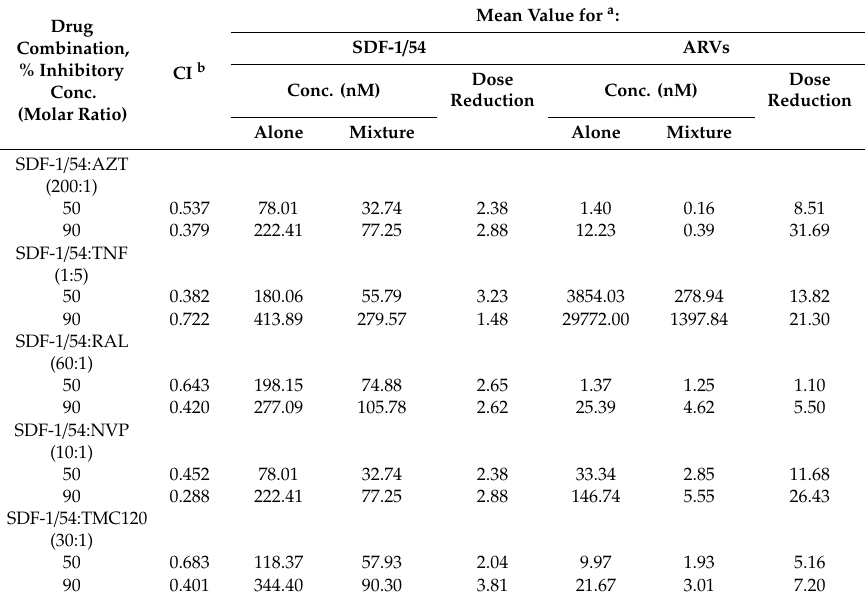
Table 6. Combination index and dose reduction values for inhibition of HIV-1NL4-3 infection by combining SDF-1 / 54 with ARVs.